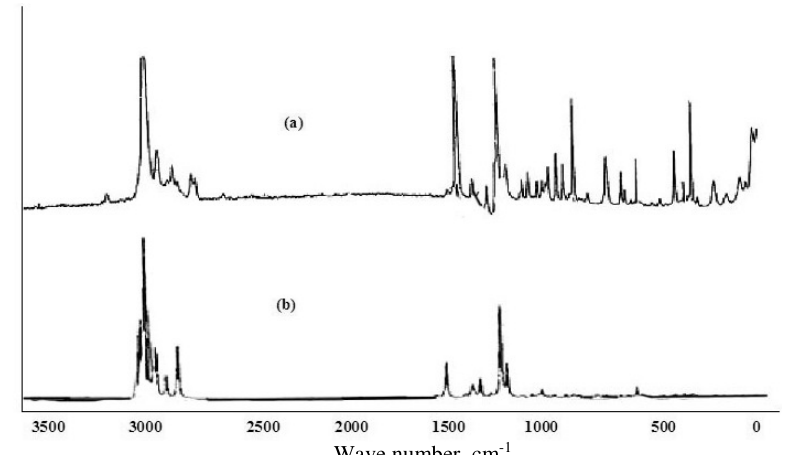
Figure 3. Comparison of observed and calculated FT-Raman 1-methoxynaphthalene (a) Observed (b) calculated with B3LYP/6-31G